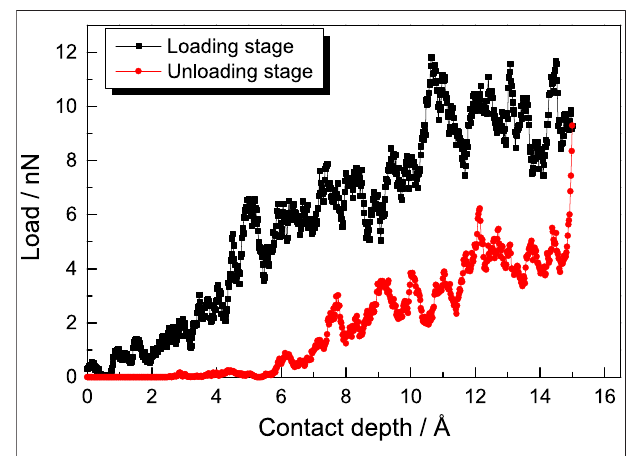
FIGURE 8 | The relationship between the loading force and contact